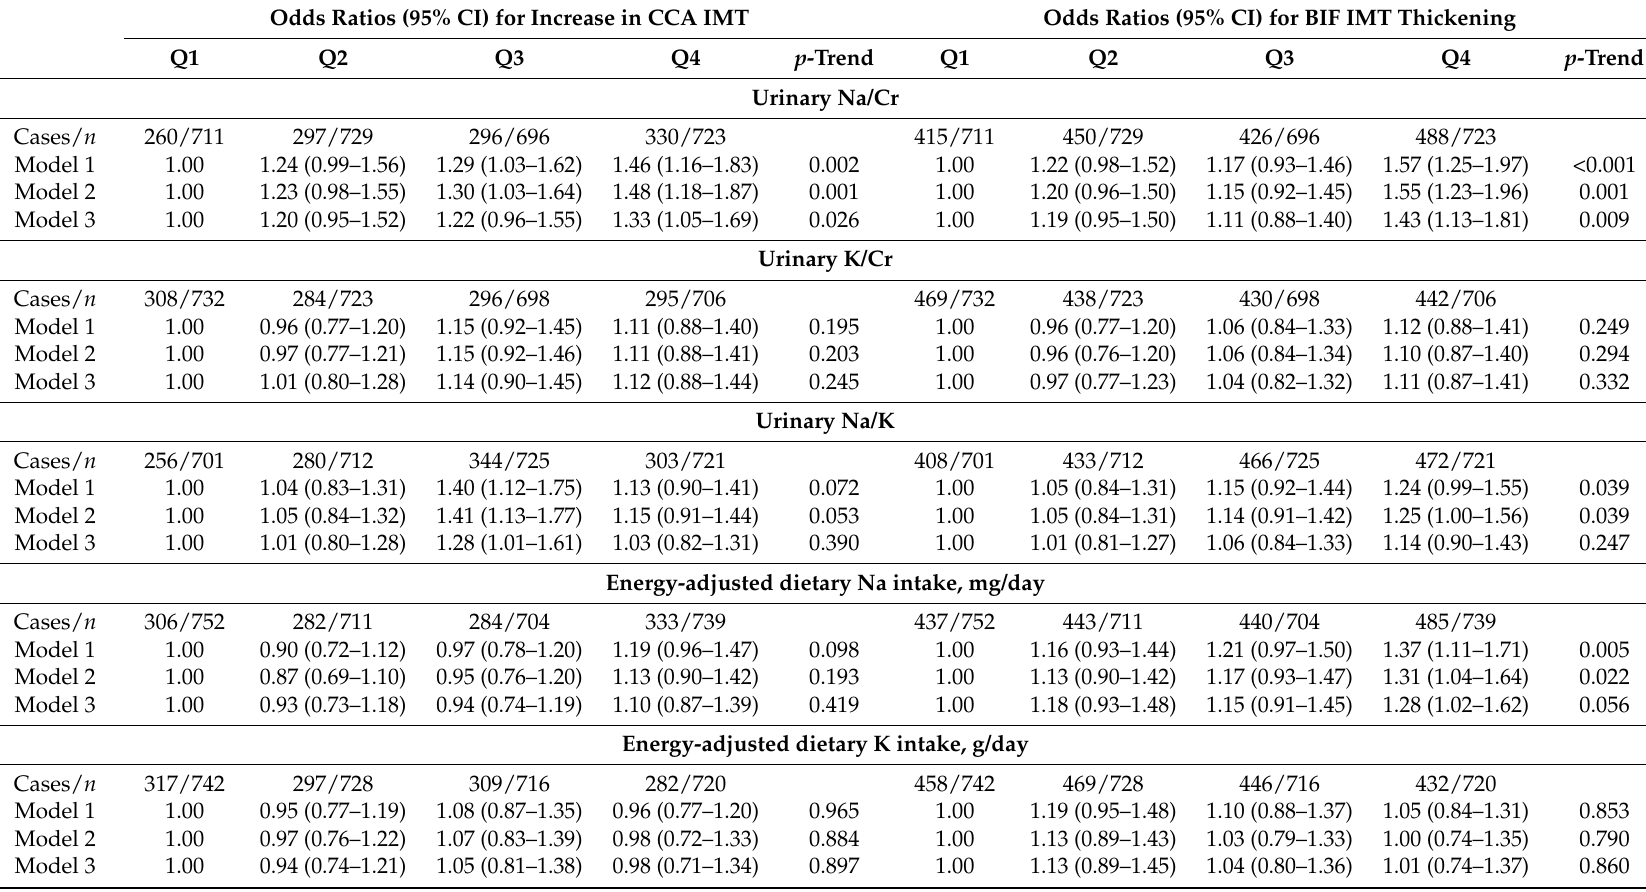
Table 3. Odds ratios and 95% CI for the prevalence of carotid intima-media thickening by quartiles (Q) of sodium (Na) and potassium (K). Odds Ratios (95% CI) for Increase in CCA IMT Odds Ratios (95% CI) for BIF IMT